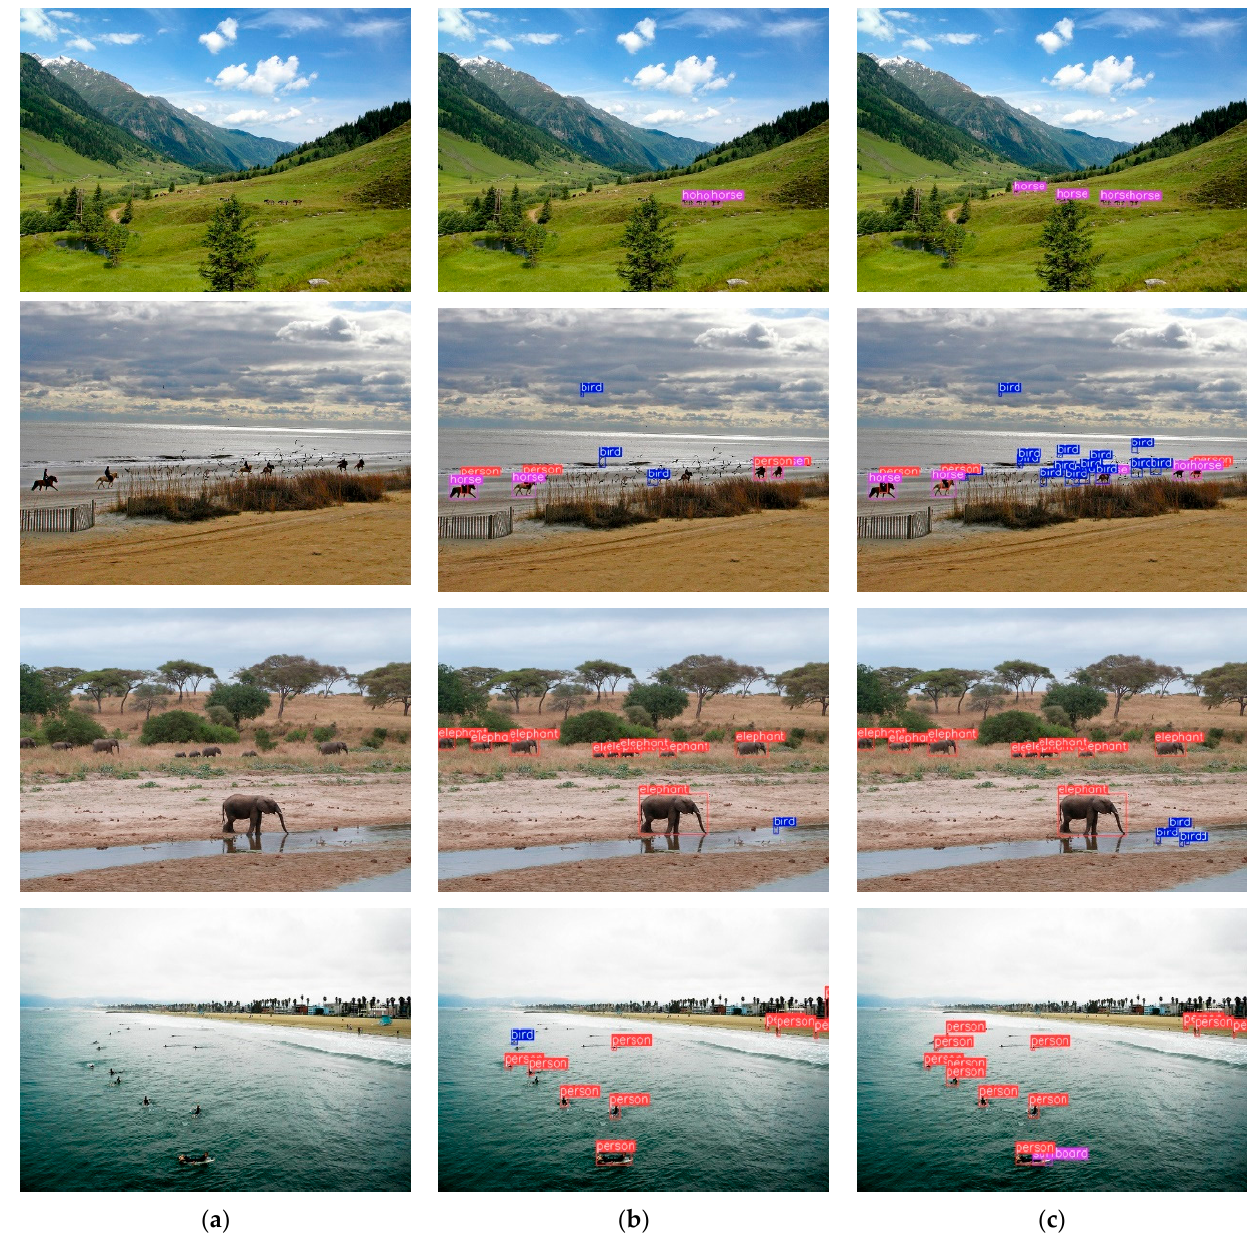
Figure 7. Comparisons of small object detection results: ( a ) the original images; ( b ) RetinaNet test results; ( c ) BFE-Net test